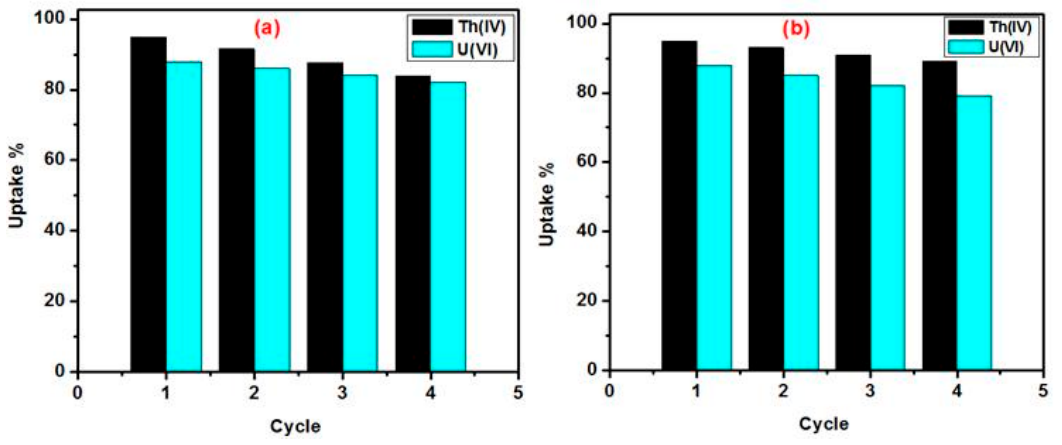
Figure 17. Recycling of U(VI) and Th(IV) loaded HQ-bentonite using ( a ) 0.25 M HCl and ( b ) 0.25 M HNO 3 . Sorption conditions: 0.1 g HQ-bentonite; 100 mg/L metal ion; 50 mL solution; U(VI) (pH 4),